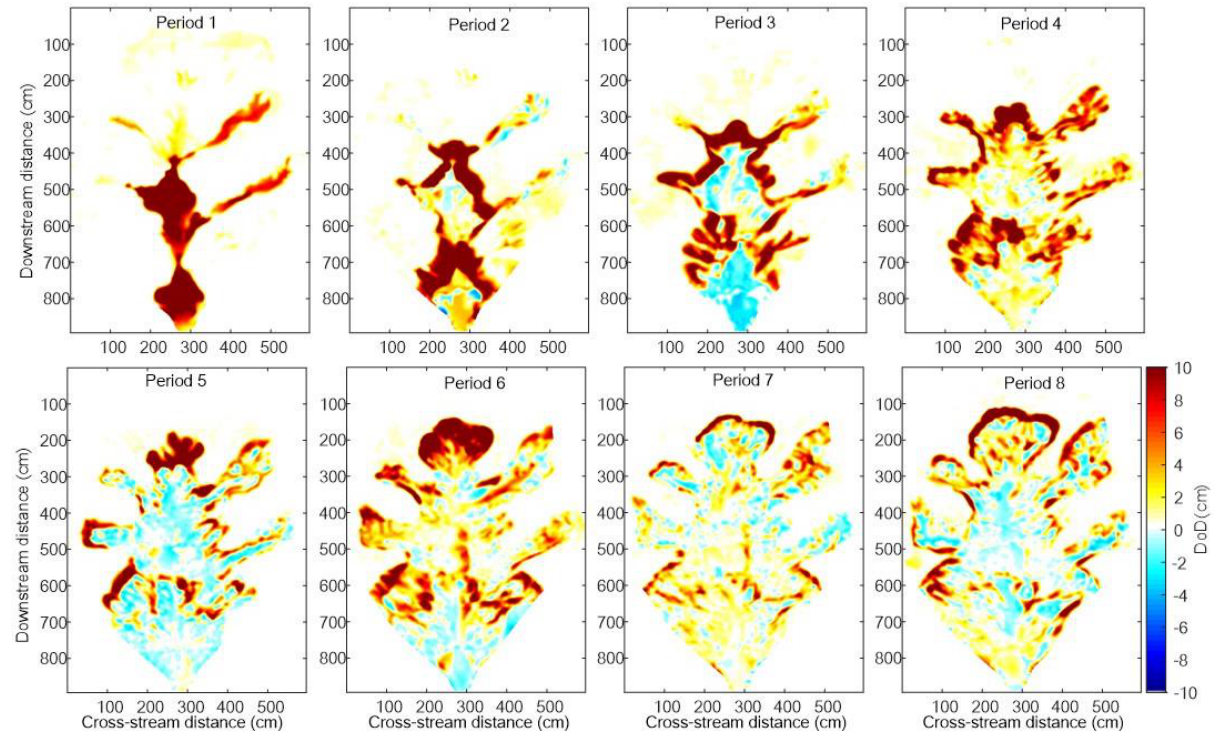
Figure 3 . morphological changes of the nine